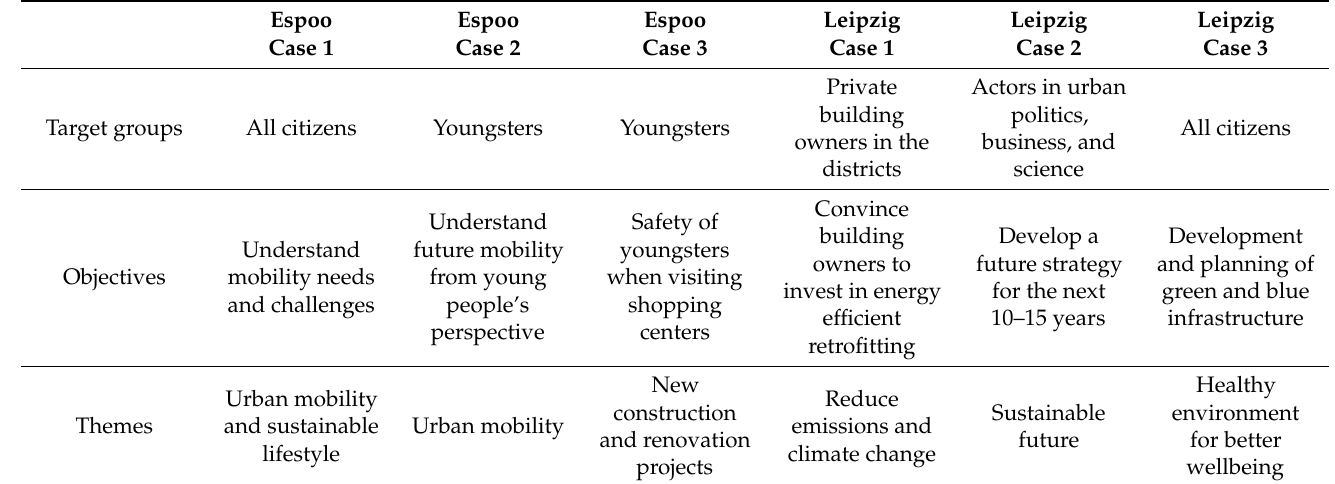
Table 1. Description of selected case